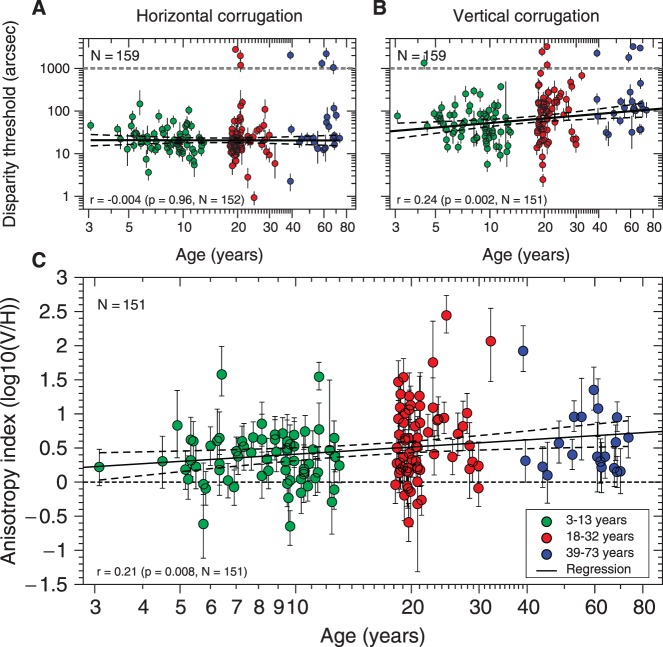
Results from Experiment 2. (A) Disparity thresholds for horizontal corrugation as a function of age. The fitted regression line for tresholds less than 1000 arcsec is Hdisp. = 10(1.32-0.0046log10[age]), (dashed lines: 95% regression confidence interval). (B) Disparity thresholds for vertical corrugation as a function of age. The fitted regression line thresholds less than 1000 arcsec is Vdisp. = 10(1.364+0.354log10[age]), (dashed lines: 95% regression confidence interval). Top gray dashed lines mark 1000 arcsec. Bottom left of each panel: Pearson correlation (log10(disparity) versus log10[age]) for tresholds less than 1000 arcsec. (C) Anisotropy index, AI = log10(V/H), as a function of age, for the 151 participants who could perform at both corrugation tasks with thresholds less than 1000 arcsec. The fitted regression line to all data is AI = 0.059 + 0.35 log10(age) (dashed lines: 95% regression confidence interval). Dashed horizontal line represents zero anisotropy. Bottom left of the panel shows Pearson correlation (AI versus log10[age]).